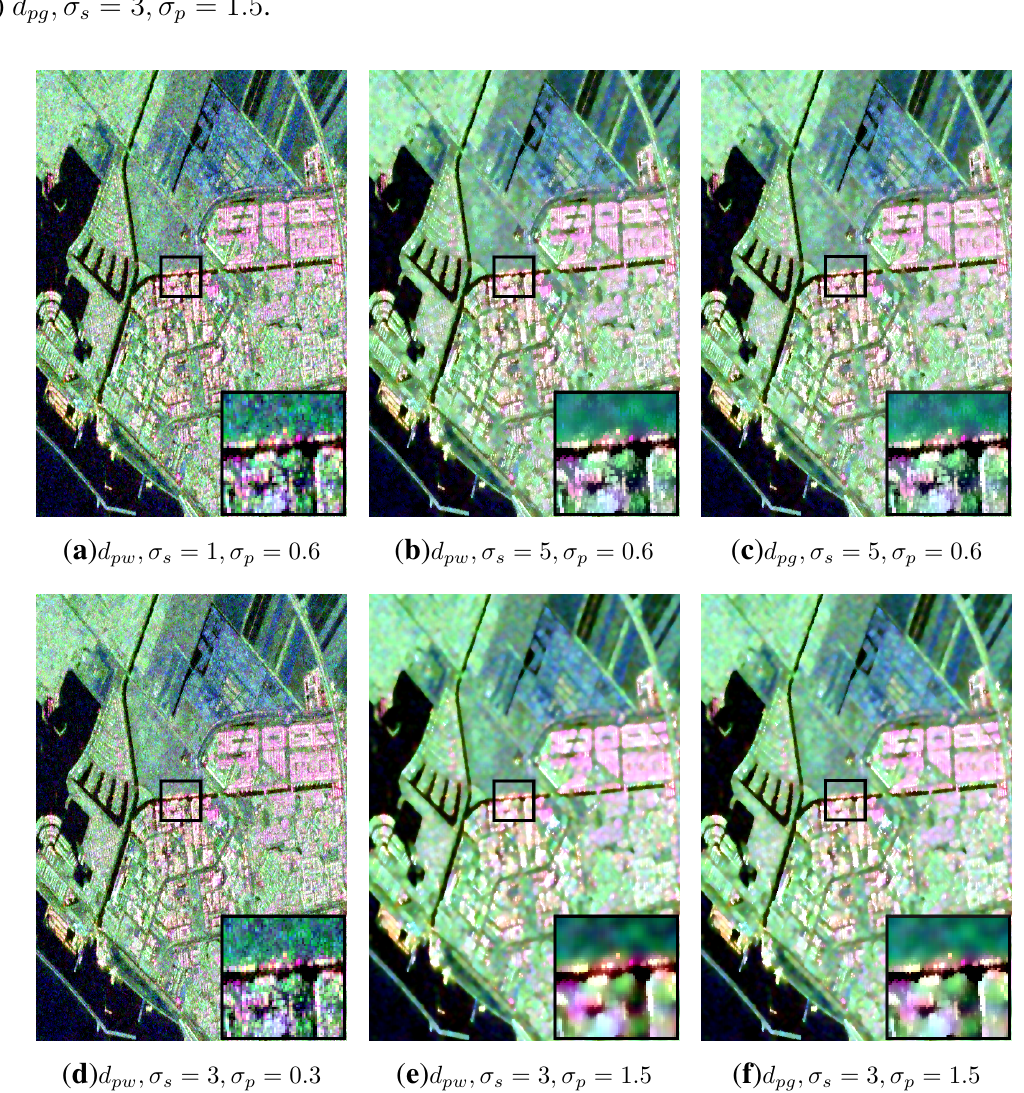
and σ with 5 weight refinement s p = 1 , σ = 0 . 6 , ( b ) d = 5 , σ = 0 . 6 , σ , σ pw s p pw s p